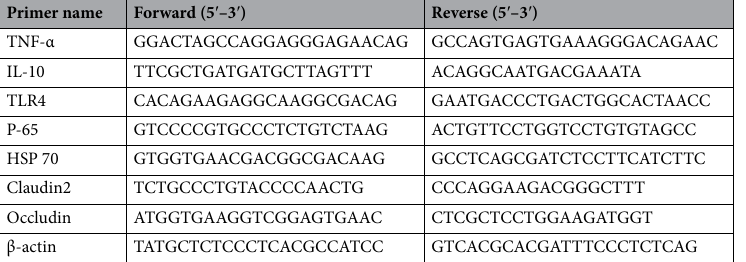
Table 1. Reactions were performed on a Bio-Rad CFX connect real-time PCR detection system (Bio-Rad Hercu- les, CA, USA). The qPCR amplification conditions were as follows: pre-denaturation at 94 °C for 30 s, followed by 45 cycles of denaturation at 94 °C for 5 s, annealing at 55 °C for 15 s, and elongation at 72 °C for 10 s. Expres- sion levels of IL-10, TNF-α, TLR-4, P-65 were calculated by the 2 −ΔΔCT method. Statistical analysis of data. All the data were statistically analyzed by Graph Pad Prism 5.0 (Graph Pad Software, Inc., La Jolla, CA, USA) and SPSS 19.0 one-way ANOVA method was used for the plotting and repre- sentation of results. Statistical significance values were set at ( P < 0.05). Ethics approval. All experimental protocols were approved by the Animal Ethics Committee of Guangdong Ocean University, China, and were performed according to the ethical guidelines of the European Community guidelines.